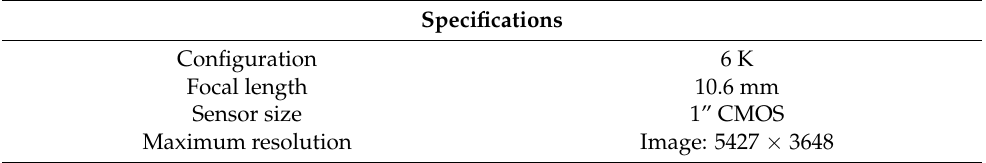
Table 4. Main features of the sensor.